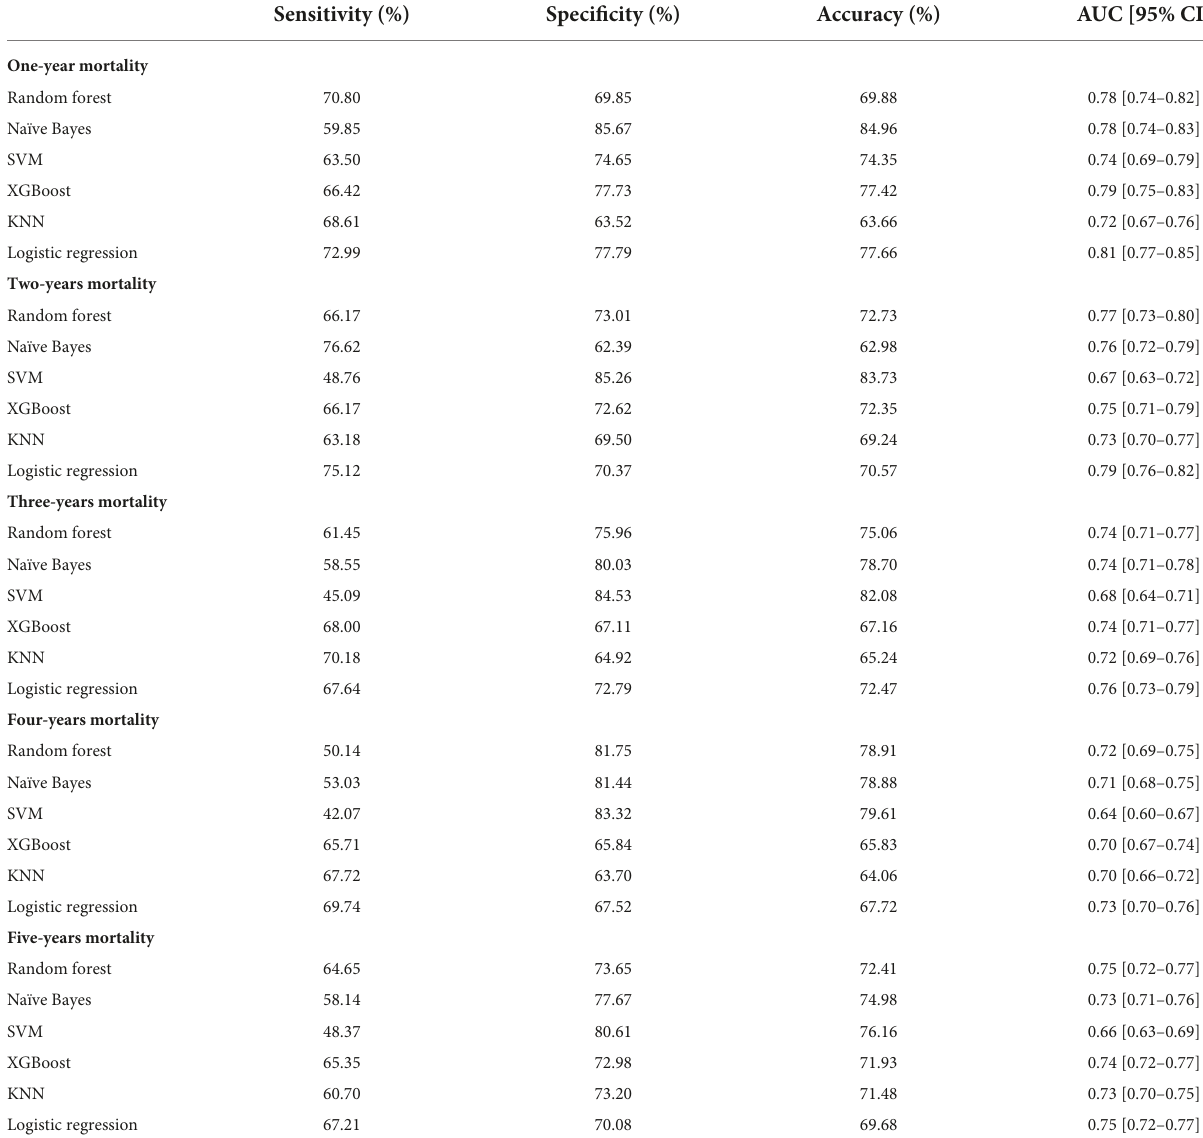
TABLE 2 Evaluation of machine learning (ML) models for each of the five follow-up endpoints. Sensitivity (%) Specificity (%) Accuracy (%) AUC [95%